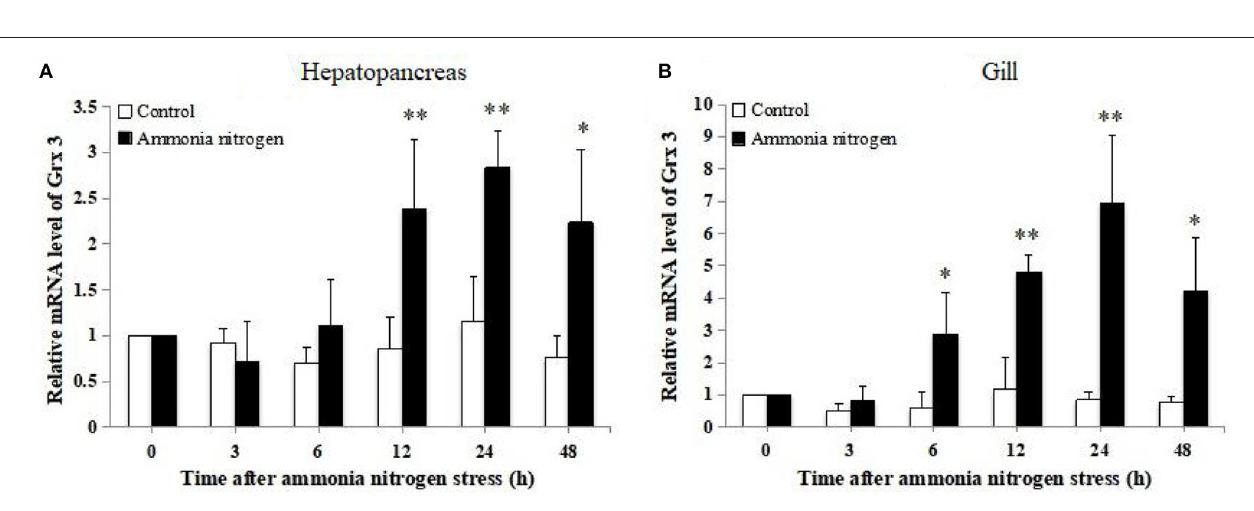
FIGURE 5 | Analysis of Grx 3 expression in (A) hepatopancreas and (B) gill of ammonia-N stress and the control groups by real-time polymerase chain reaction (RT-PCR) at 0, 3, 6, 12, 24, and 48h post-stress ( n = 9). Statistical significance was calculated using Statistical Package for the Social Sciences (SPSS) 18.0 (* P < 0.05; ** P < 0.01; *** P <